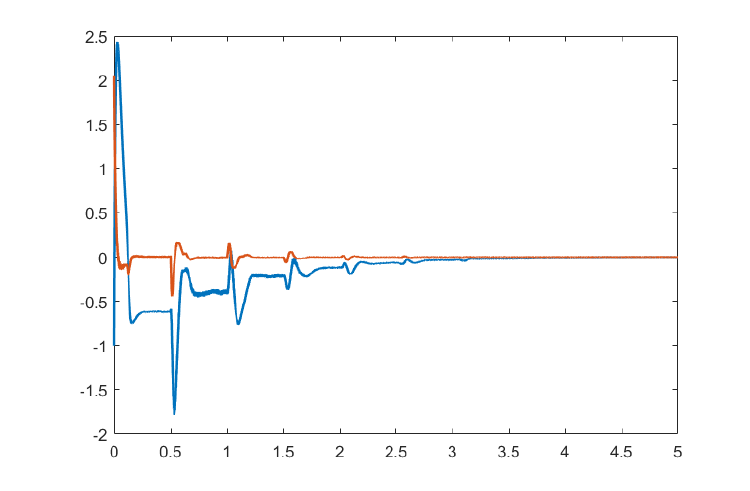
Figure 6. The state trajectories of closed-loop systems with initial conditions ( − 2, 2).